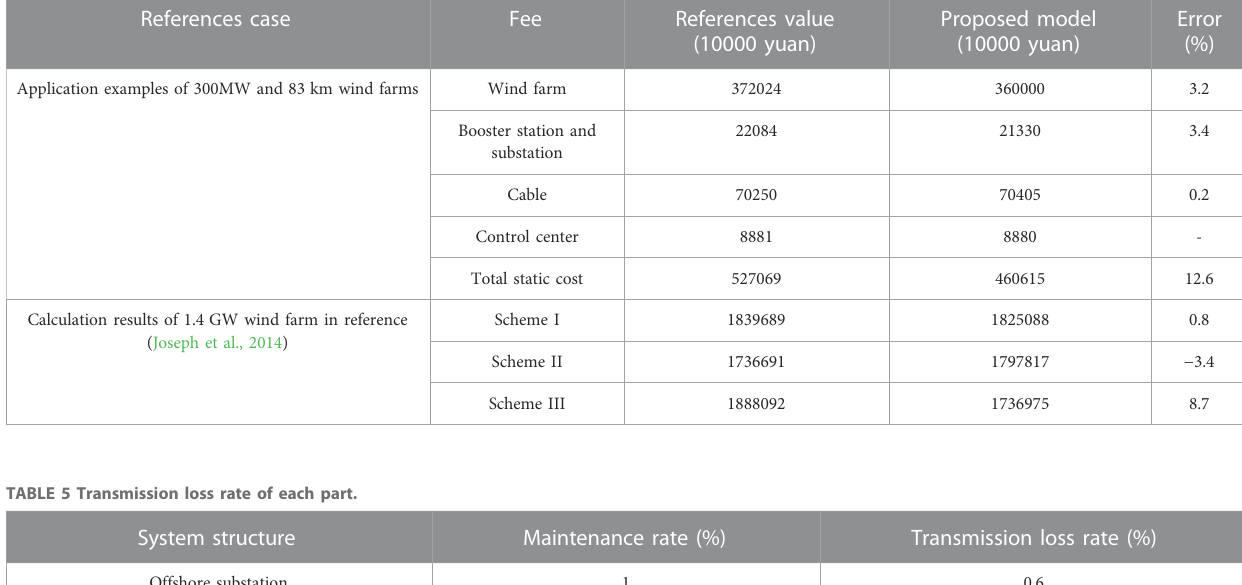
TABLE 4 Cost analysis of transmission distance of 80 km under 300MW and 1400 MW capacity.